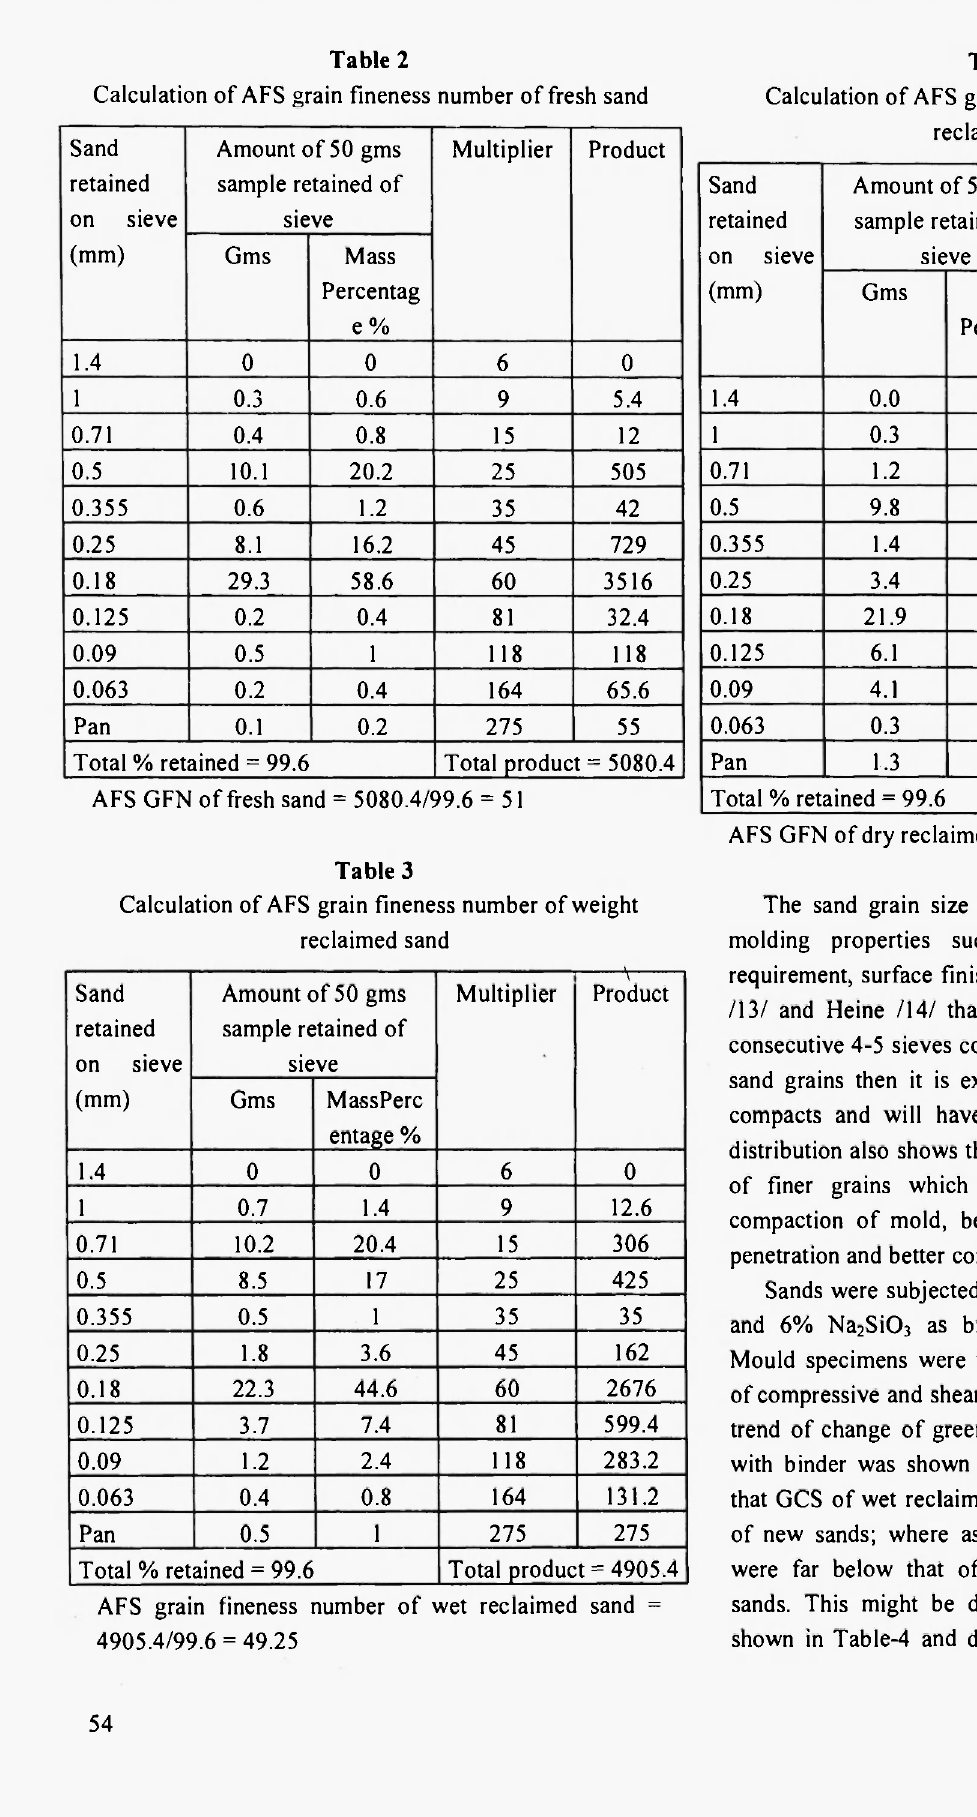
Calculation of AFS grain fineness number of fresh sand